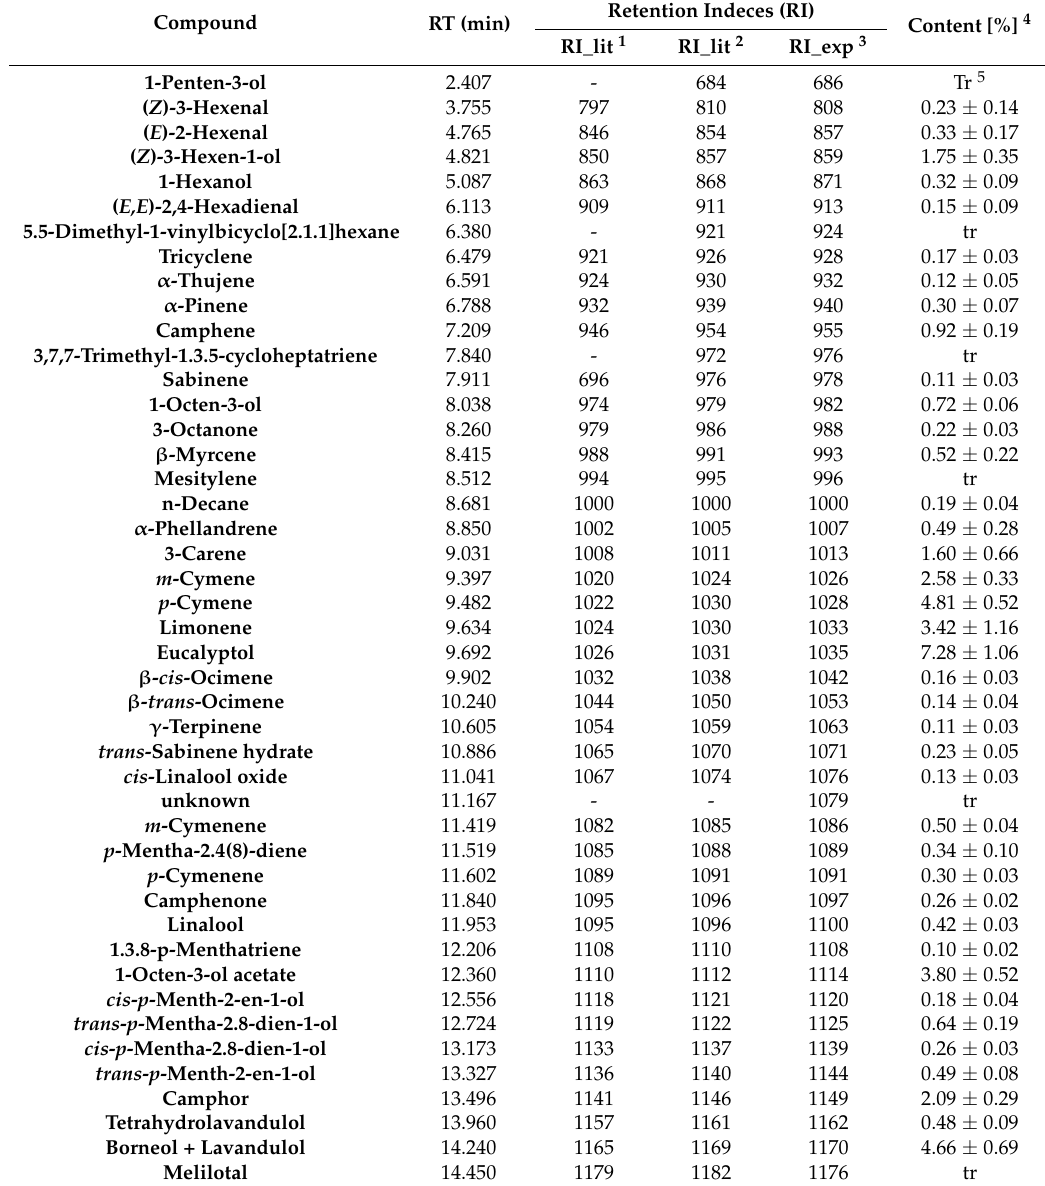
Table 2. Volatile constituents of fresh true lavender